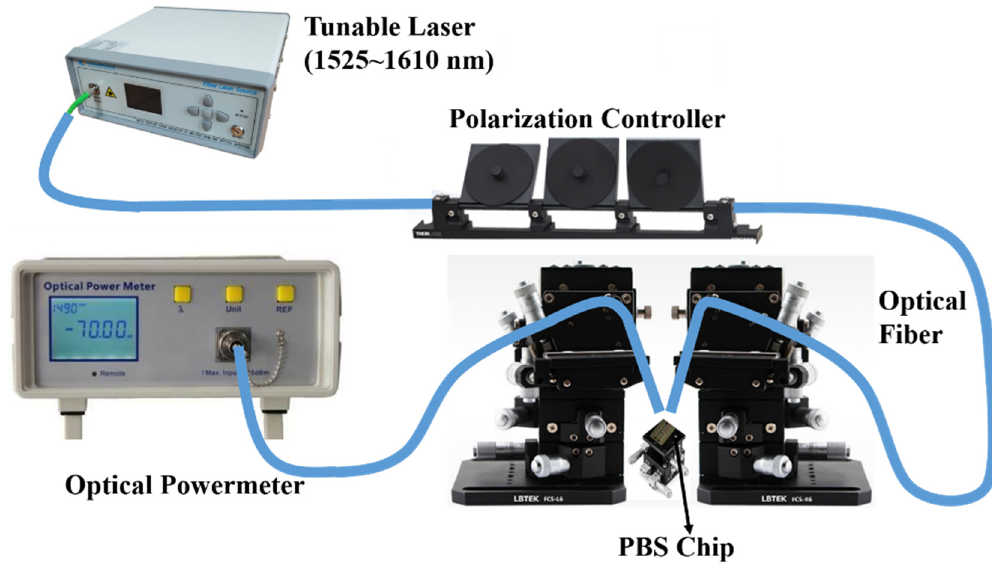
7 of 10 Figure 7. ( a ) Microscope image of the chip under test and ( b ) SEM image of the fabricated device. For device characterization, a schematic of the experimental setup is illustrated in Figure 8. A tunable laser was used, and the wavelength of the input light was tuned from 1525 to 1605 nm with a step of 2 nm. An optical powermeter was applied as the receiver for the measurement of the transmittance at the output port. Figure 9a shows the meas-